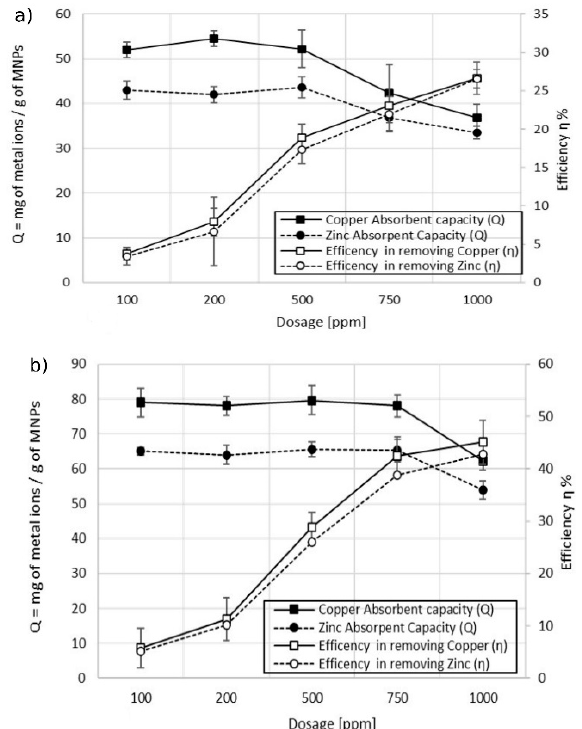
Figure 10. Effect of contact time on the adsorption capacity in the removal of Cu 2+ and Zn 2+ . ( a ) MA with 5% w/w coating and ( b ) MA with 10% w/w coating, pH 7.2.